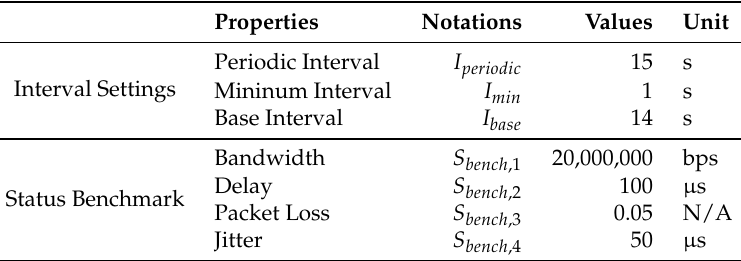
Table 2. An example of adaptive MonLink